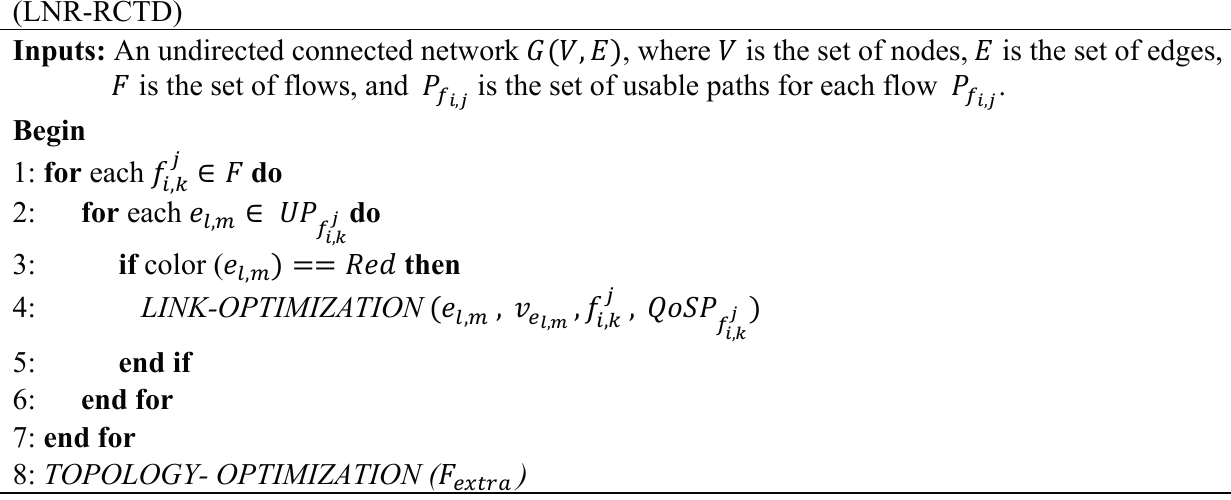
Algorithm 1: Link and Node Removal Considering Residual Capacity and Traffic Demands